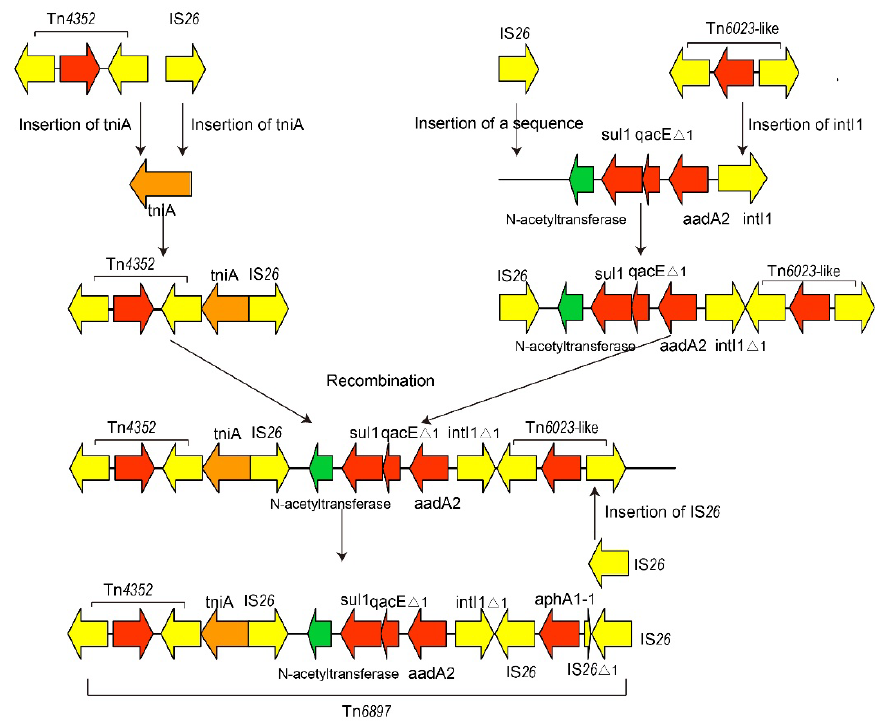
Figure 4. Genealogy of Tn6897 in plasmid pYhe2001. Due to the lack of DRs flanking IS26 as well as specific target site duplication patterns, the novel Tn6897 could be hypothesized to produce by IS26 recombination and other transposons .